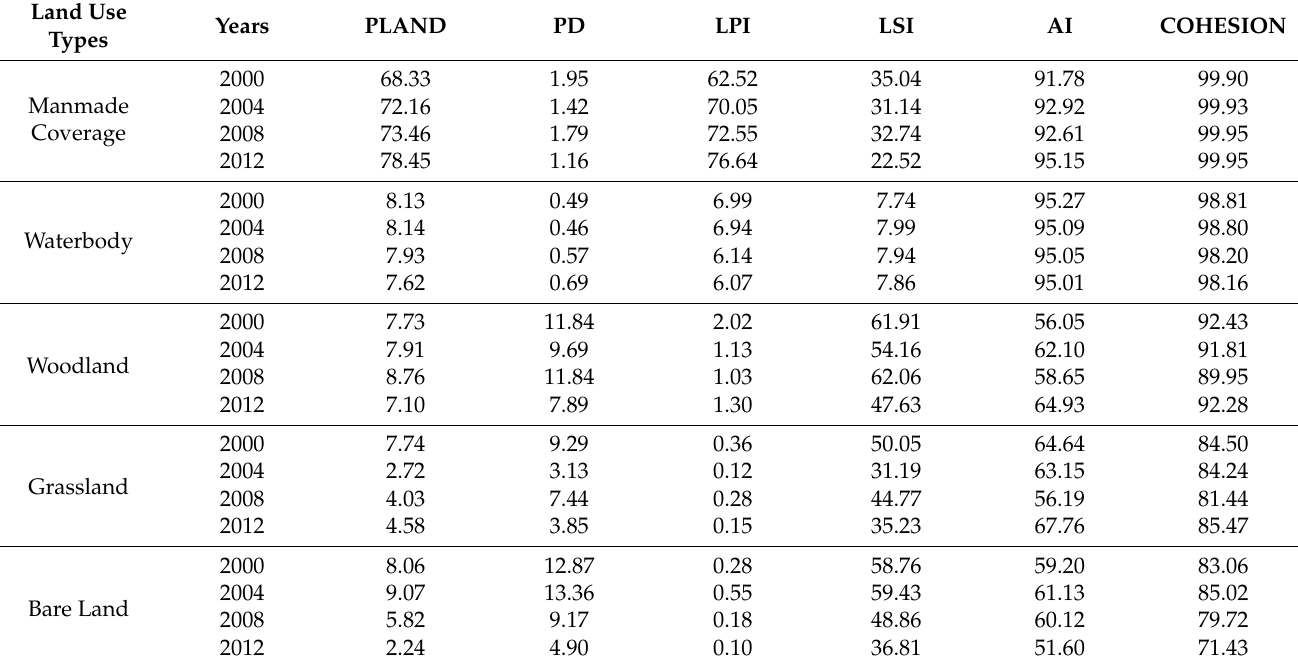
Table 4. Class-level metrics change from 2000 to 2012.